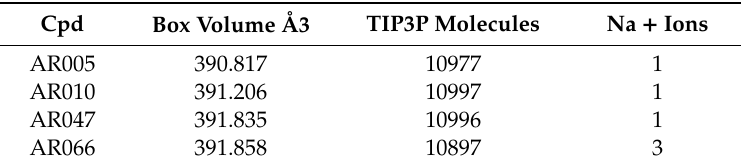
Table 2. Characteristics of the simulated